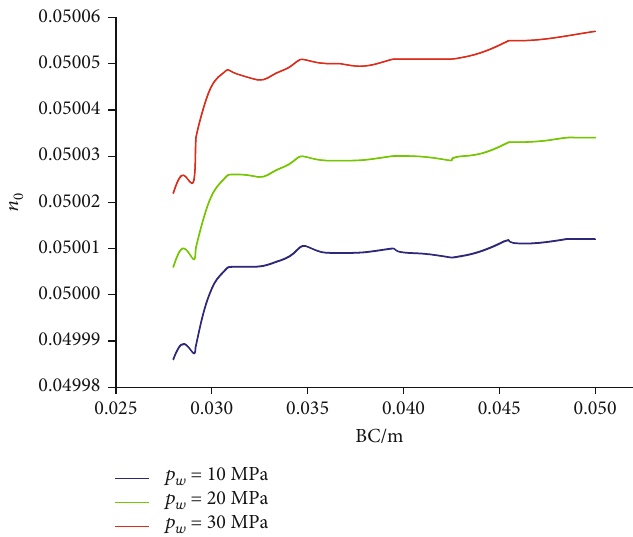
Figure 7: The rock porosity in the monitoring line